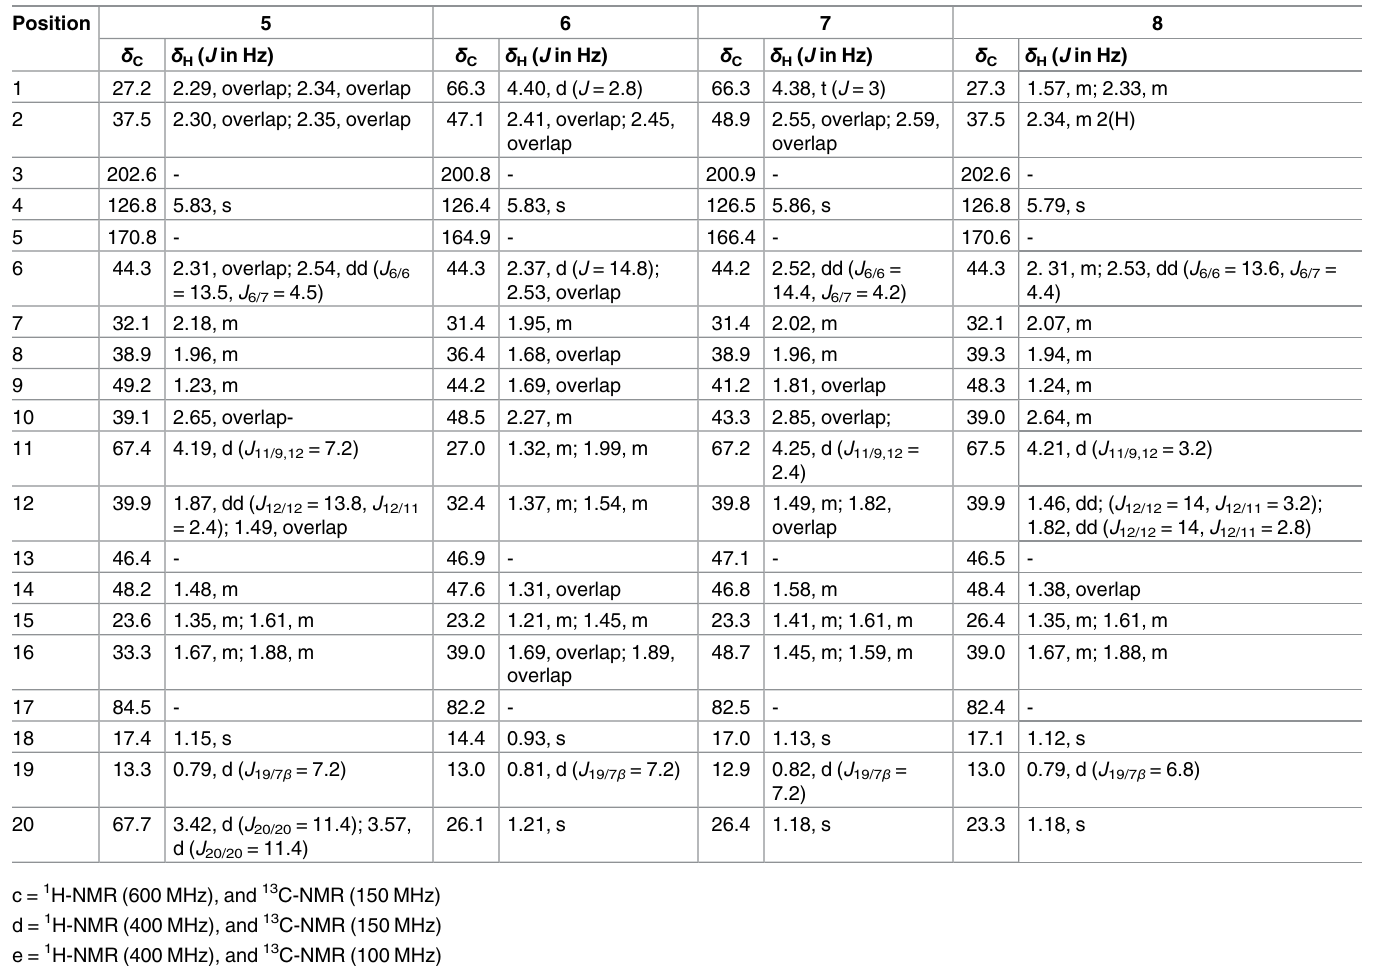
Table 2. 13 C- and 1 H-NMR chemical shift data ( J in Hz) of compounds 5–8 ( δ